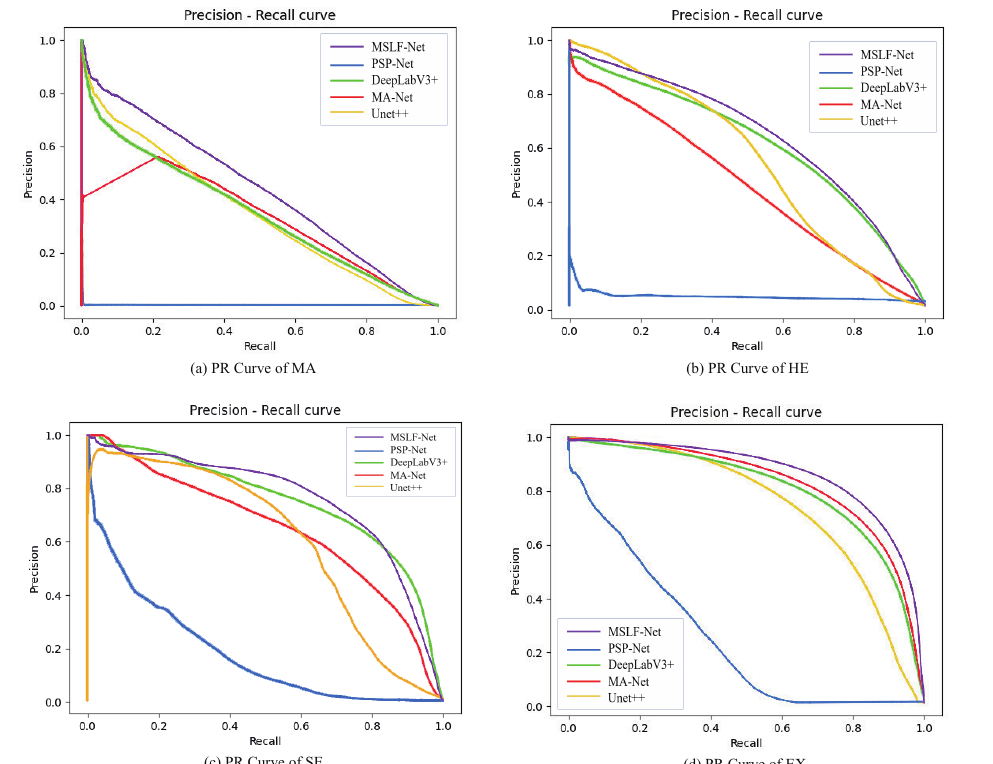
Figure 7. PR curves of MSLF-Net on